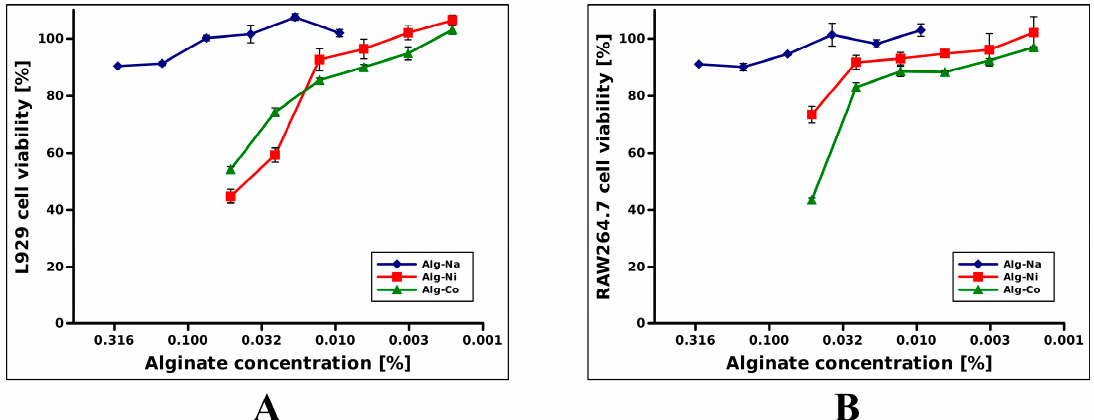
Figure 3. Cytotoxicity evaluation of nickel (II) and cobalt (II) alginates on different cell lines. ( A ) L929 cell viability; ( B ) RAW264.7 cell viability. Cell viability values were normalized considering positive control (cells cultured in DMEM alone) as having 100% viability. All samples were in triplicate. Values are represented as mean ±+/- SEM. X axis is log transformed.